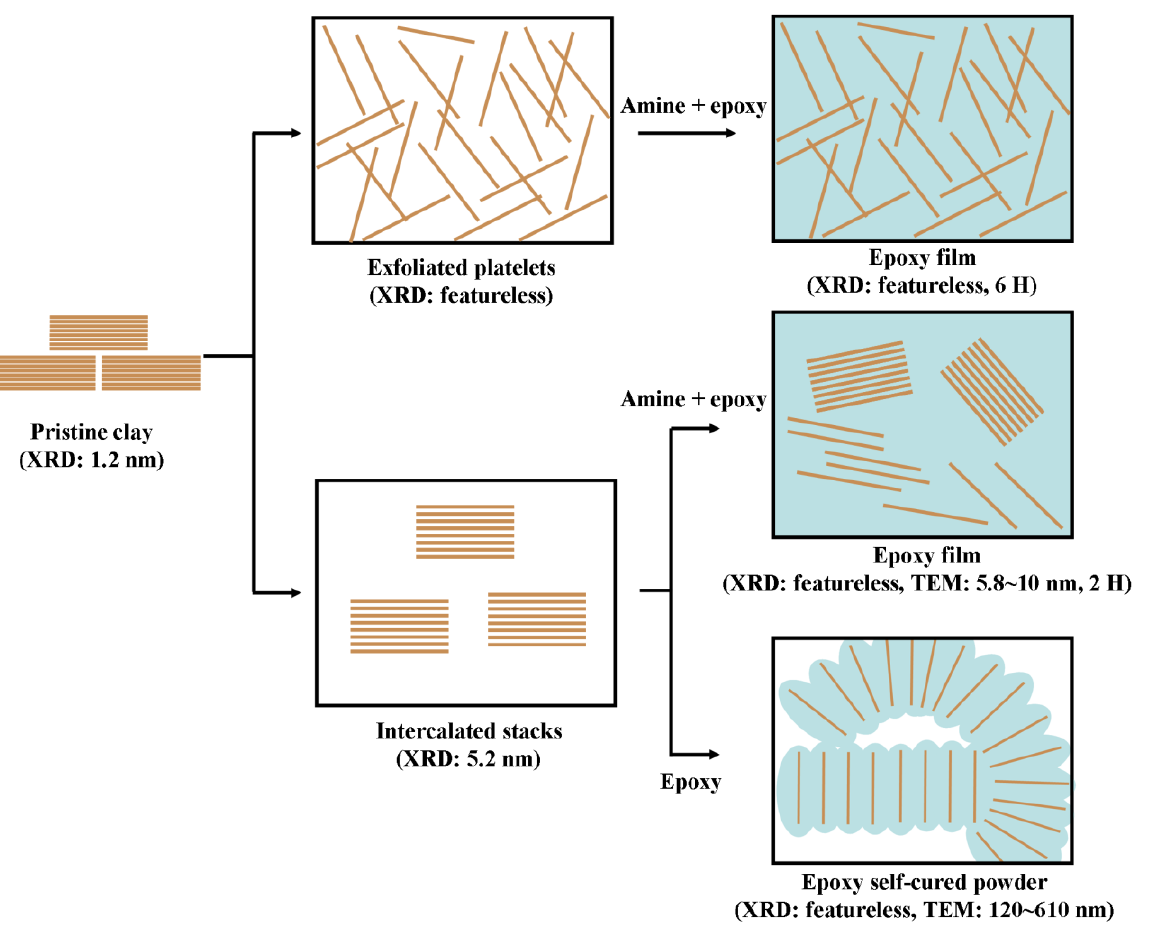
Figure 8. Conceptual illustration of two types of amine-cured epoxy films and clay- initiated epoxy